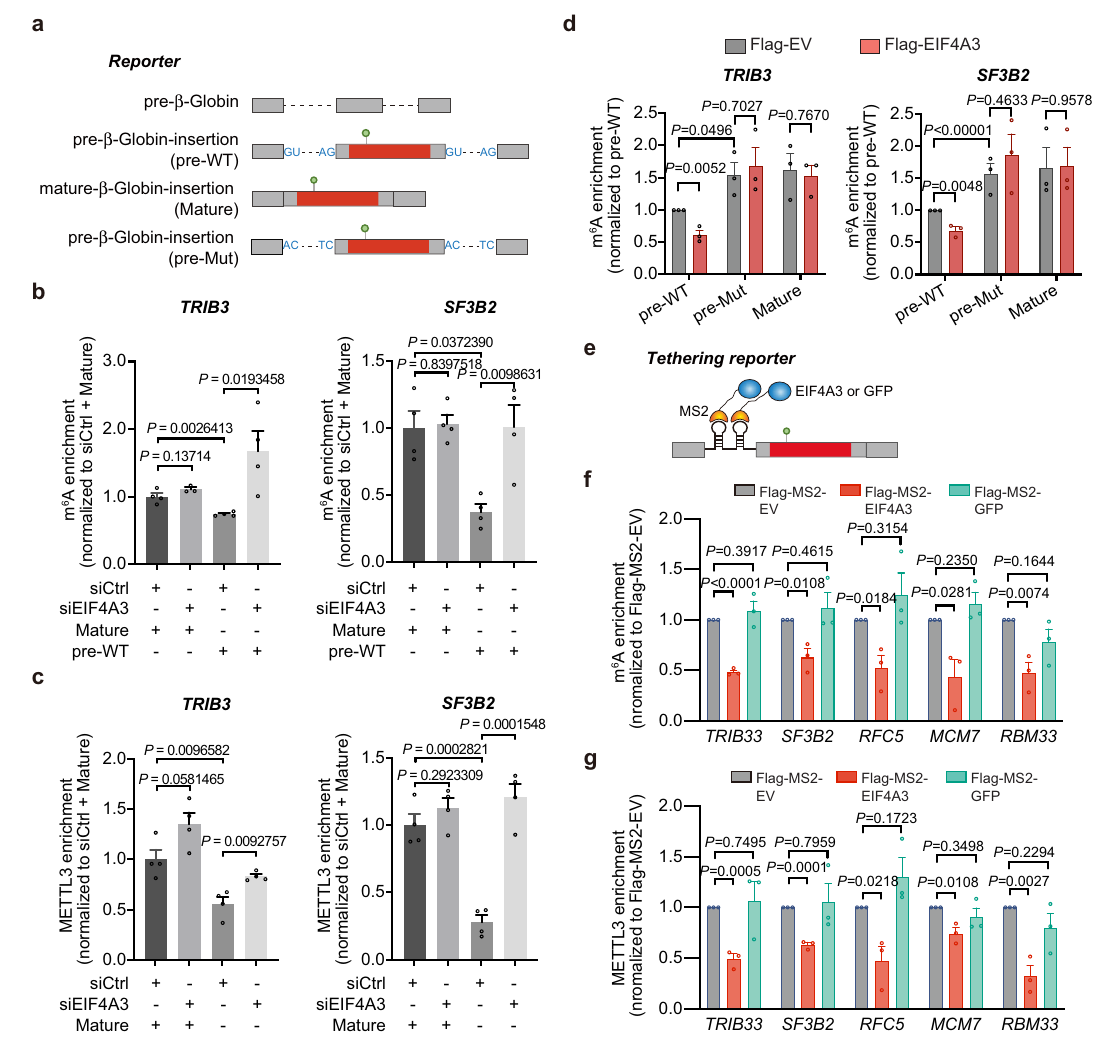
Fig. 4 | EIF4A3 blocks METTL3-mediated m 6 A modi fi cation during mRNA maturation. a Schematic of reporter constructs. Grey boxes and dash lines pre- sent the exons and introns of mouse beta-globin, respectively. Red boxes present the exons of candidate genes with hypermethylated m 6 A (green dot). GU/AG splicing mutation is indicated. b , c meRIP-qPCR ( b ) and METTL3 CLIP-qPCR ( c ) analysisofreporterconstructsshowingm 6 AandMETTL3enrichmentuponEIF4A3 KD. Data are mean±S.E.M. ofthree independent experiments.Statistical analyses, two-tailed Student ’ st-test. d meRIP-qPCR analysisof pre-WT,pre-Mut,andMature